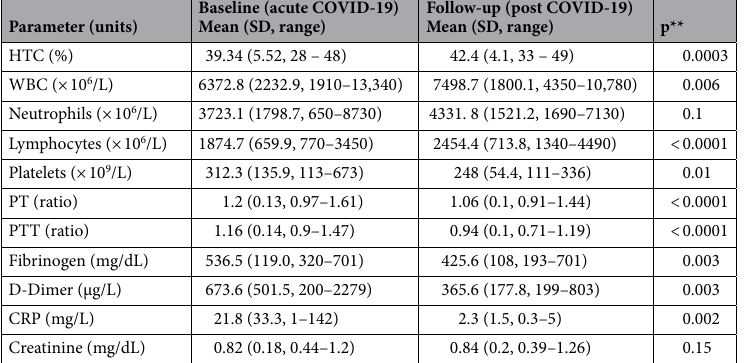
Table 2. Laboratory parameters* in COVID-19 patients enrolled in the study (N = 32). COVID-19 Coronavirus disease 2019, SD standard deviation, HTC hematocrit, WBC white blood cells, PT prothrombin time, PTT partial thromboplastin time, CRP C-reactive protein, LDH lactic acid dehydrogenase, CK creatine kinase. *The closest available within 3 days prior to the fundus examination at baseline and the same day of fundus photos at follow-up. **T test (paired).